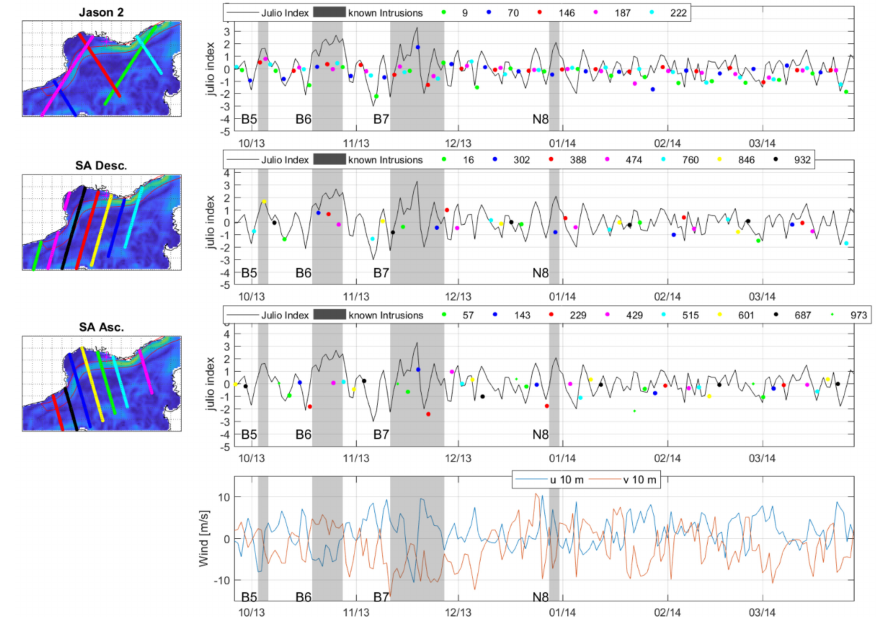
Figure 5. Results of the application of the regressive random forest algorithm to observational data, (Jason 2 and Saral / Altika). Right panel shows the map of the tracks considered for the period 26 September–31 December 2013, and the corresponding comparison between J ind and Fn p top to bottom, Jason 2, Saral / Altika Descending and Ascending tracks, please note the color code (same for maps and comparison panels) as specified in the legend. The lower panel shows the mean daily horizontal winds. The periods corresponding to well-known intrusion events are highlighted in gray in all